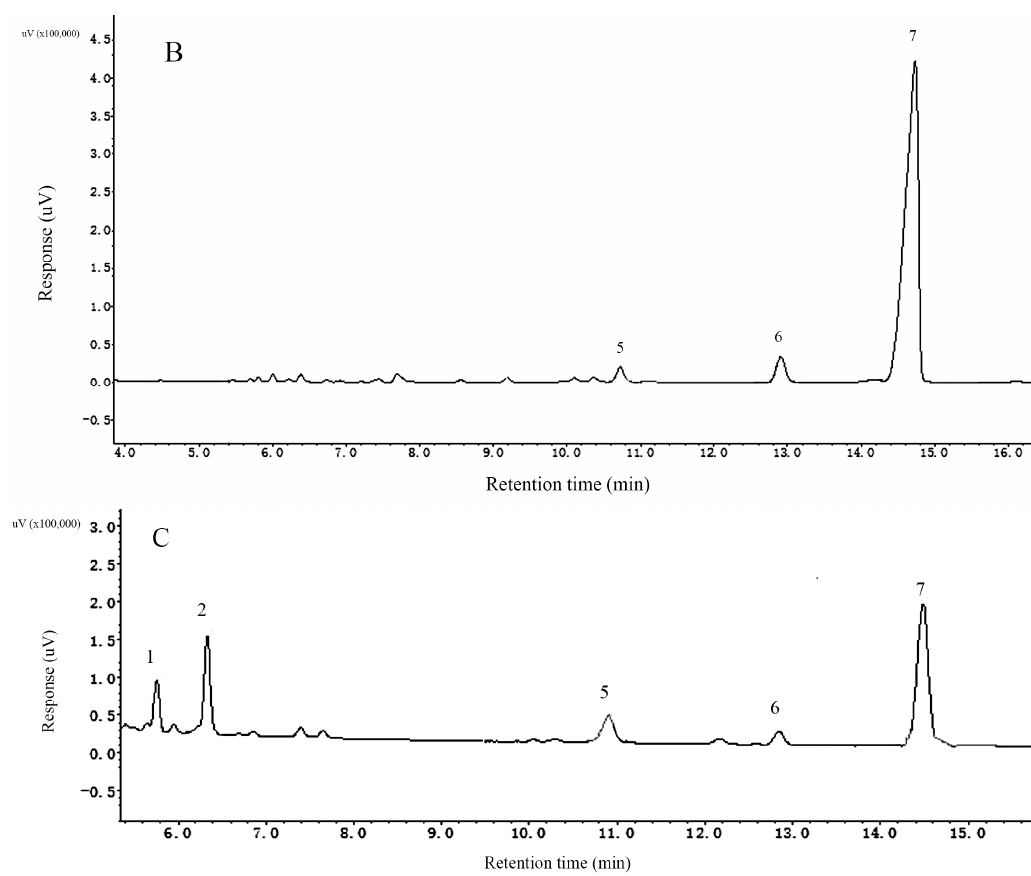
Figure Figure 2. Gas chromatogram profiles of monosaccharide standards, ACP1-1 and ACP2-1. ( A )